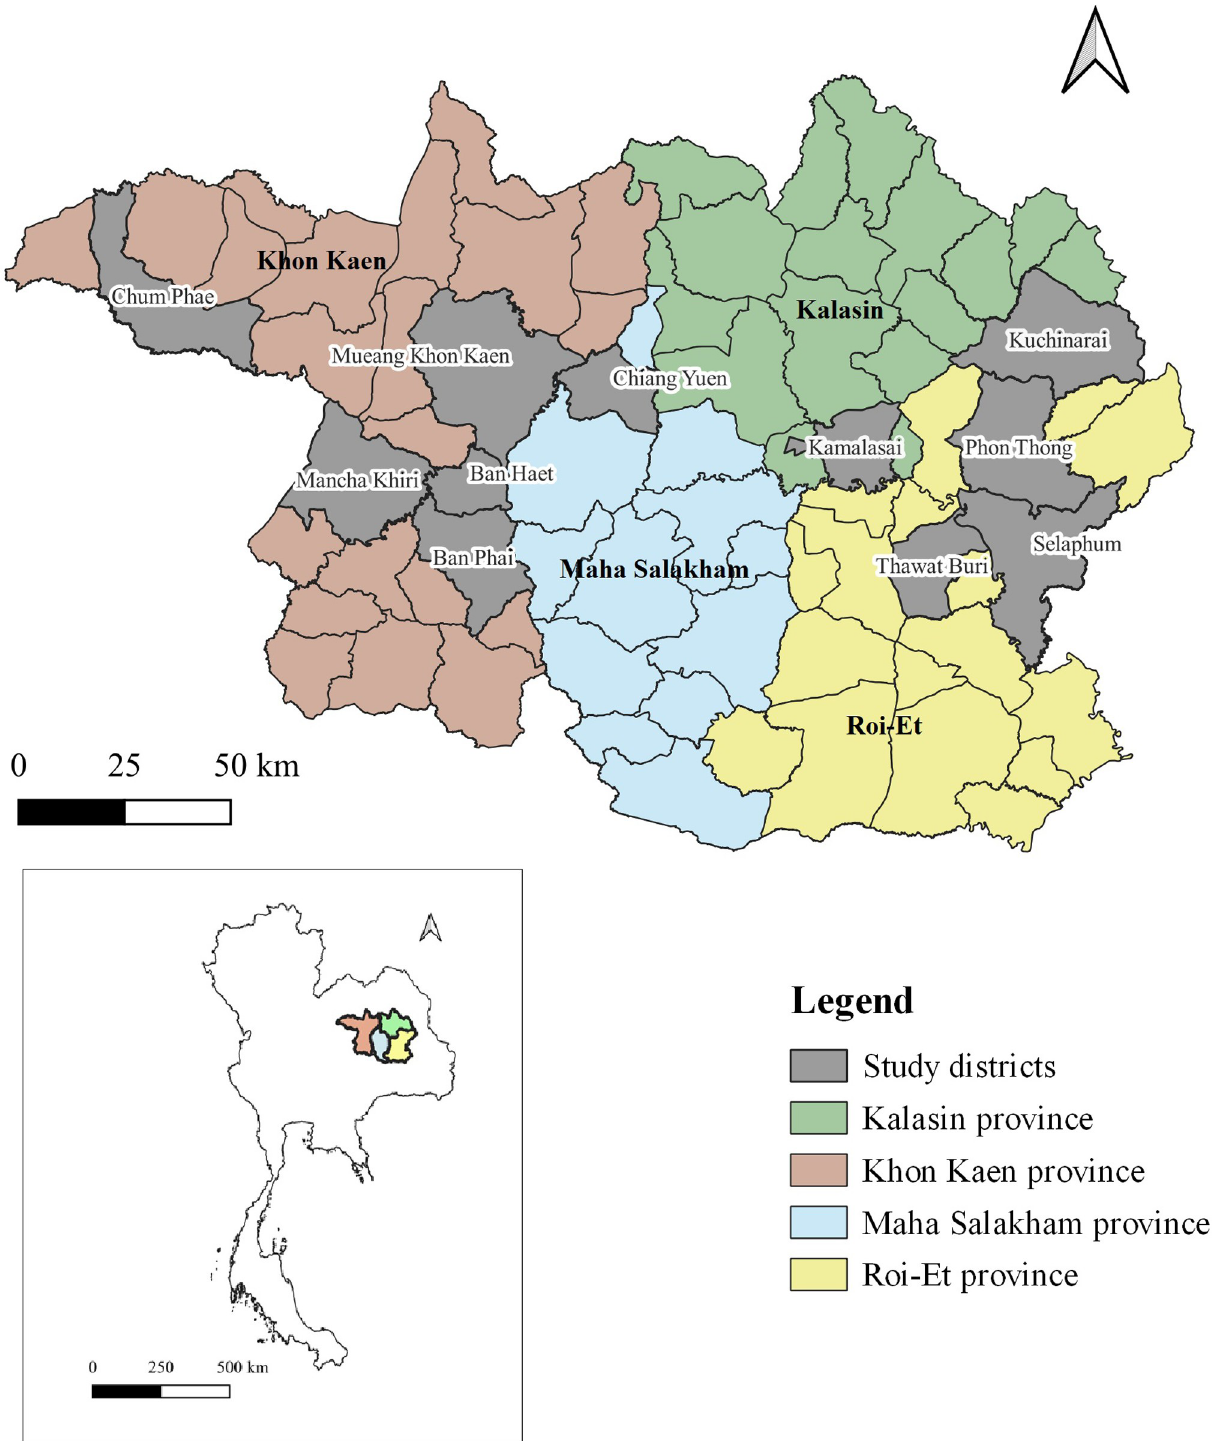
Fig 1. Map of the study area. Sample collections were done in four provinces of northeastern Thailand which are highlighted in green, brown, blue, and yellow. The locations of study districts are marked on the map in gray. The map was created using QGIS 3.16 software.